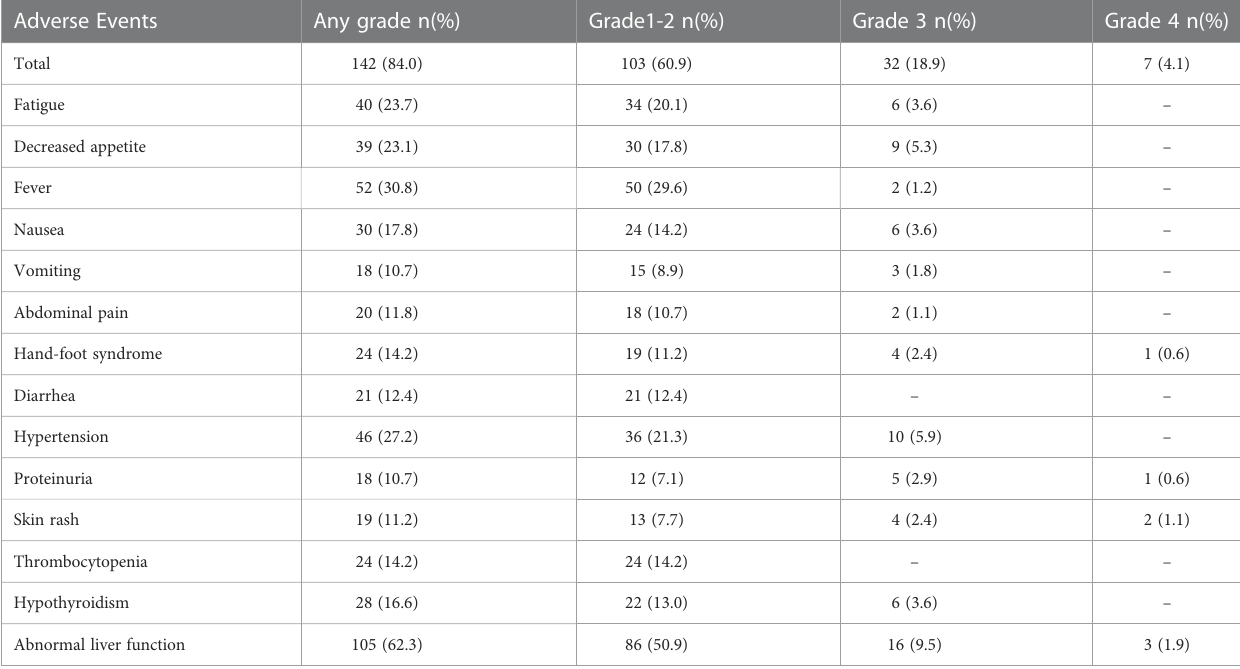
TABLE 2 Treatment-related adverse